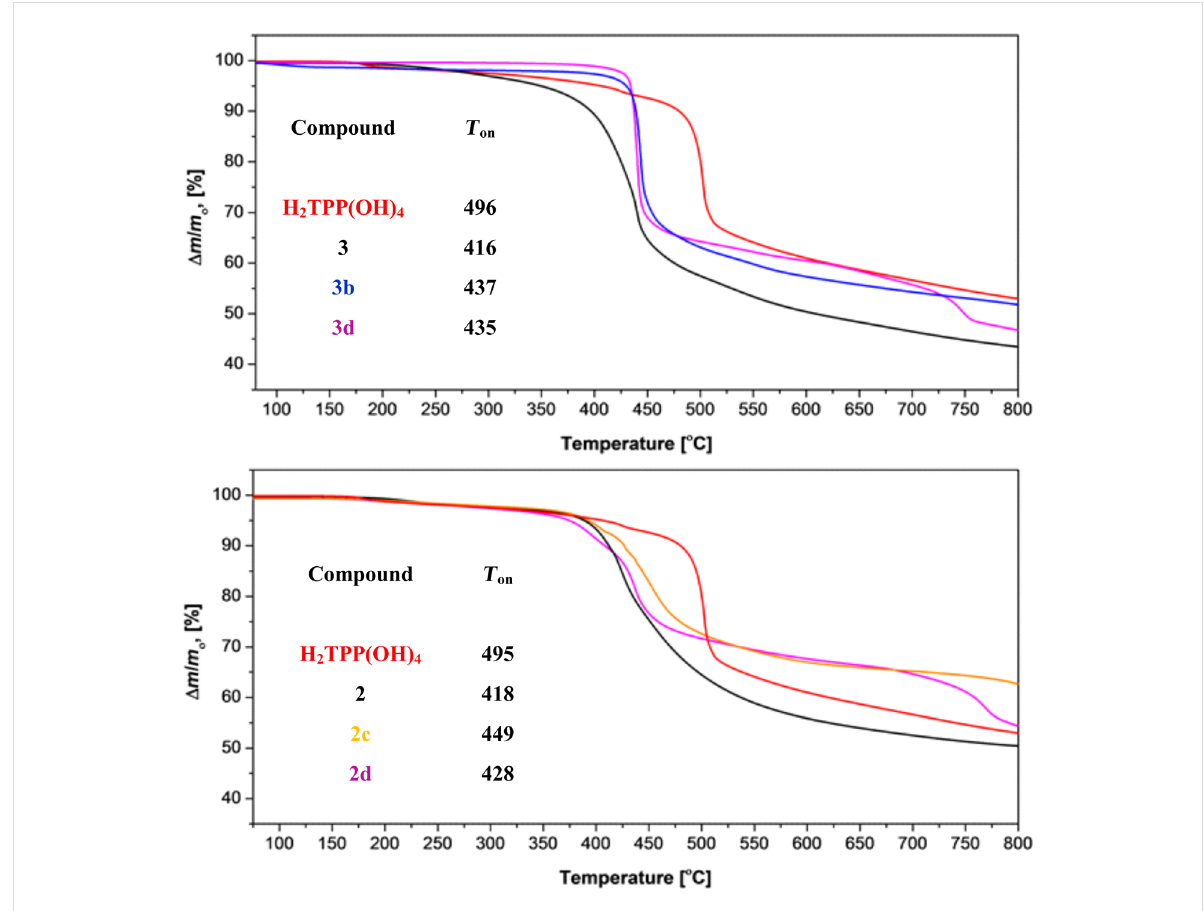
Figure 5: Top: TG traces of 3 , 3b and 3d in comparison with H 2 TPP(OH) 4 . Bottom: TG traces of 2 , 2c and 2d in comparison with H 2 TPP(OH) 4 .